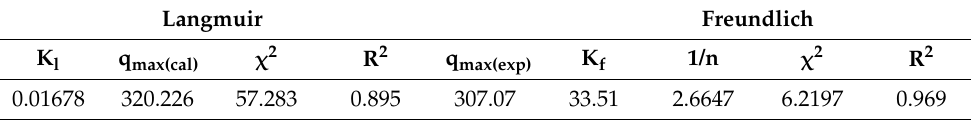
Table 3. Parameters of Langmuir and Freundlich models of Cr(VI) adsorption upon TIHP. Langmuir